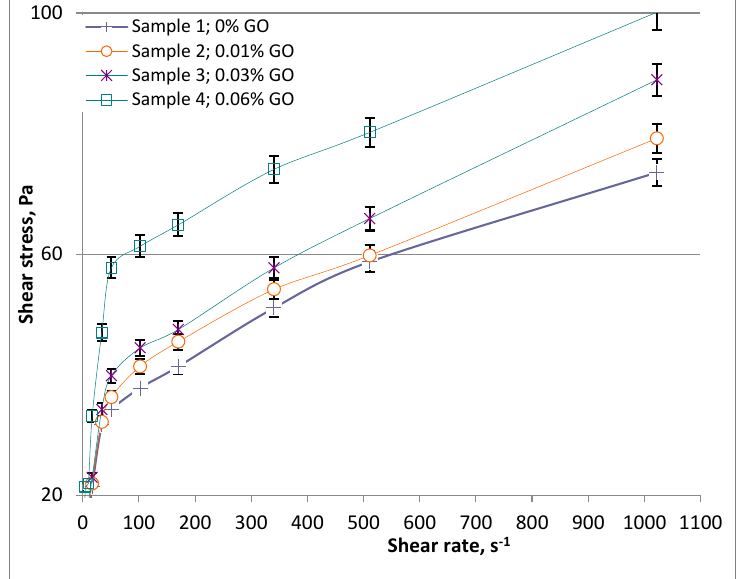
Figure 1. Graph of shear stress dependence on shear rate for slurries containing graphene oxide without a latex admixture. Energies 2020 , 13 , x FOR PEER REVIEW